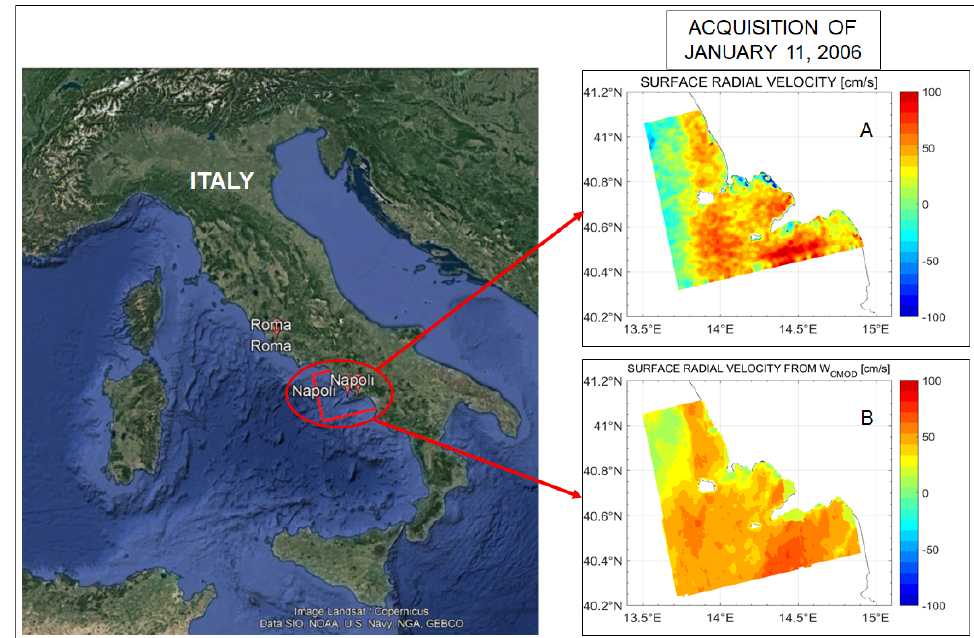
Figure 3. Test site presented in [281], situated along the coast of southern Italy. The middle panel displays a zoomed-in view of the area of interest. The right panel shows the sea surface velocity map obtained from the ATI technique [281].